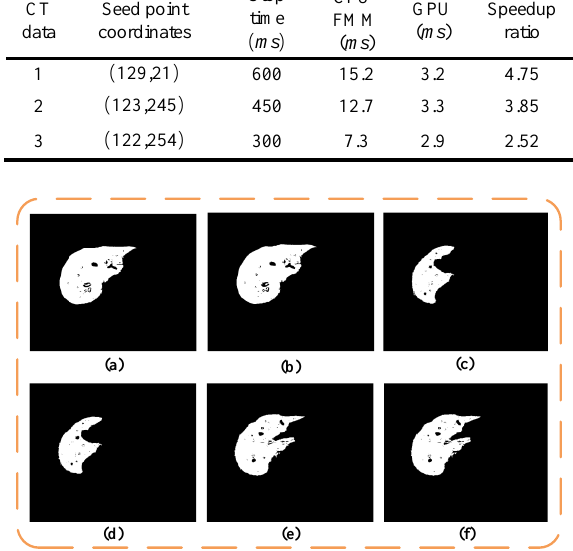
Table1. GPU vs. CPU time for 3 different CT datasets CT data